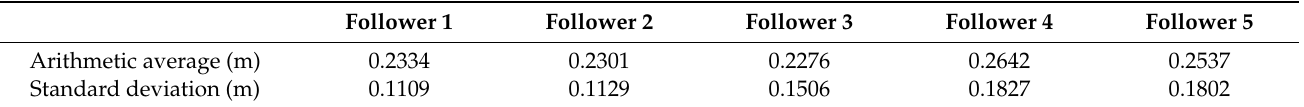
Table 7. The average distance and standard deviation between the follower and leader routes at a speed of 2 m/s in flight around the perimeter of the rectangle.